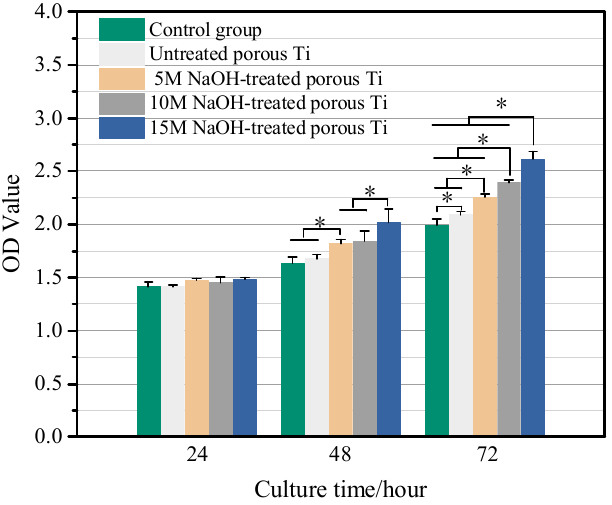
Figure 11. Proliferation of BMSC on different porous titanium surfaces, * p < 0.05, n = 3.